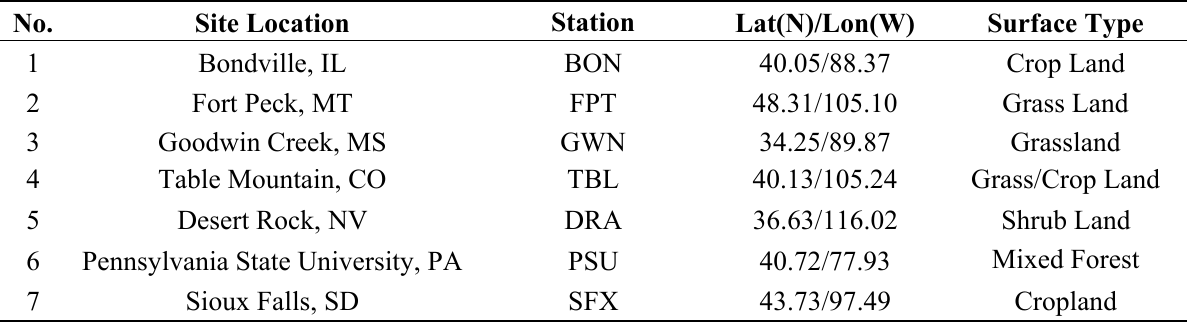
Table 1. Geo-Location and surface type of the seven SURFRAD